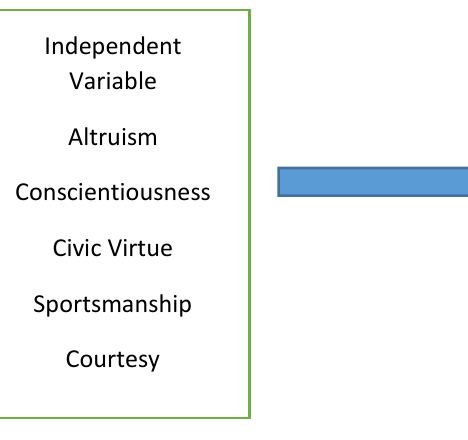
Fig. 1. Theoretical framework of the proposed study